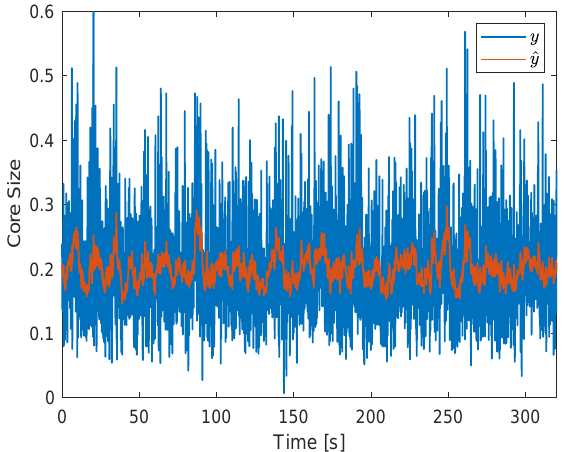
Figure 25. Controlled core size in the presence of a square wave disturbance in the air flow rate of the experimental facility. In blue: original ERT signal. In orange: output of the low-pass filter ( ω f = 1 rad/s). Signals with standard deviation σ ( y ) = 0.0801 and σ ( ˆ y ) = 0.0227.